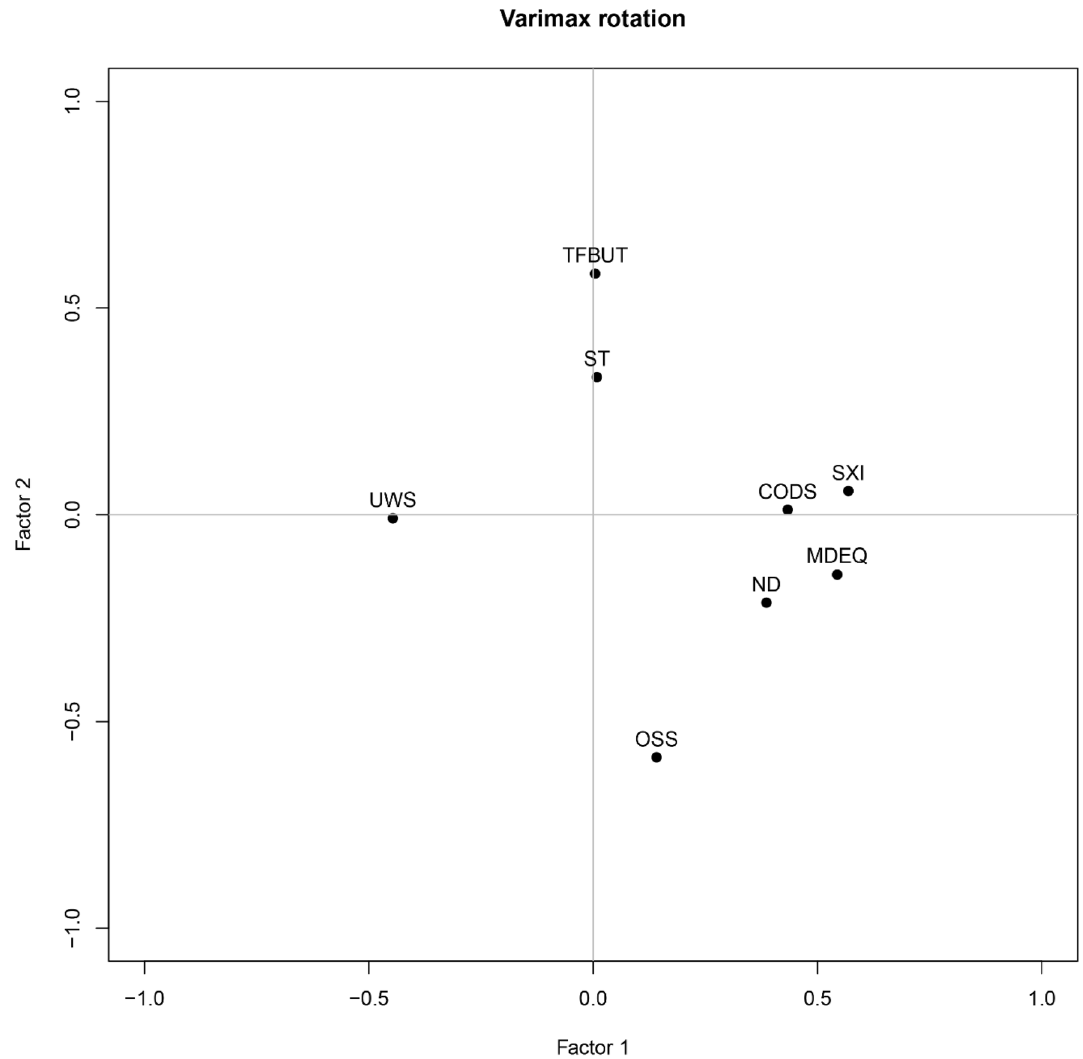
Figure 3. Loading pattern of the influences of the two factors on DED and dry mouth variables after varimax rotation. MDEQ McMonnies dry eye questionnaire, OSDI Ocular Surface Index questionnaire, TFBUT tear film breakup time (s), OSS ocular surface staining, ST Schirmer I test (mm/5 min). Oral parameters — UWS unstimulated whole saliva (mL/min), SWS stimulated whole saliva (mL/min), CODS clinical oral dryness score, SXI Summated Xerostomia Inventory, ND number of